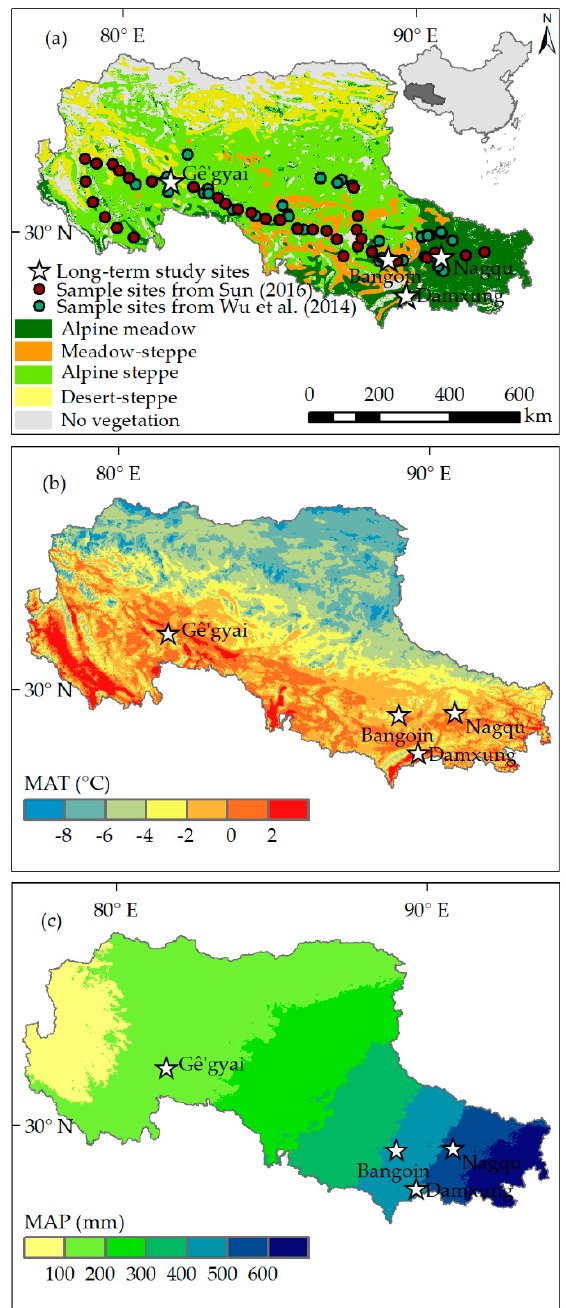
Figure 1. Vegetation and climate on the northern Tibetan Plateau. Panel ( a ), alpine grassland types; Panel ( b ), mean annual temperature (MAT) of 1979–2008; Panel ( c ), mean annual precipitation (MAP) of 1979–2008. The four sites shown with white stars, were chosen in Damxung, Nagqu, Bangoin, and Gê'gyai, which represent for meadow-steppe, alpine meadow, alpine steppe, and desert-steppe, respectively, for a long-term research plan. The long-term AGB peak dataset measured from 2009 to 2016 at the four sites were used to build a model to estimate AGB peak at the regional scale. Two more independent datasets of short-term AGB peak measured by Sun [47] (red circles) and Wu et al. [48] (green circles) were used to validated the best-fitted model.